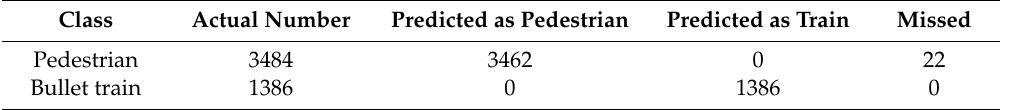
Table 11. Experimental results on the railway test set.